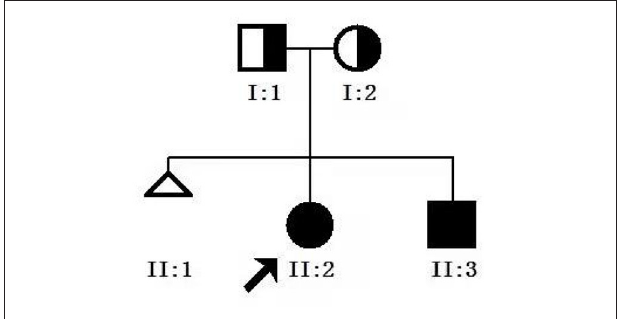
FIGURE 1 | Genetic pedigree map for the proband. I:1, father; I:2, mother; II.2, proband; II.3, younger brother.